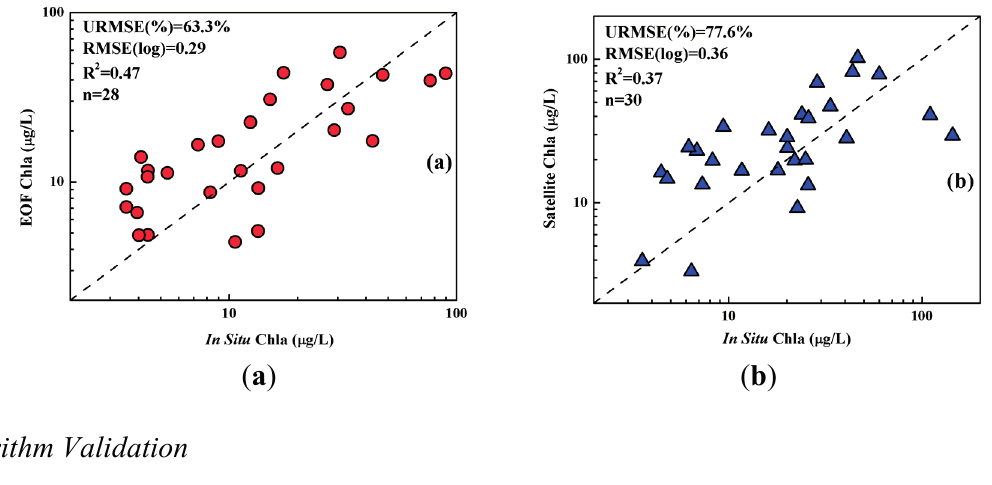
Figure 3. ( a ) Comparison between field measured Chla at the 28 stations (Figure 1) and Chla derived from the MODIS Rrc using the EOF model; ( b ) Validation of the EOF model using independent field measurements from the six fixed stations (Figure 1). The dashed lines are 1:1